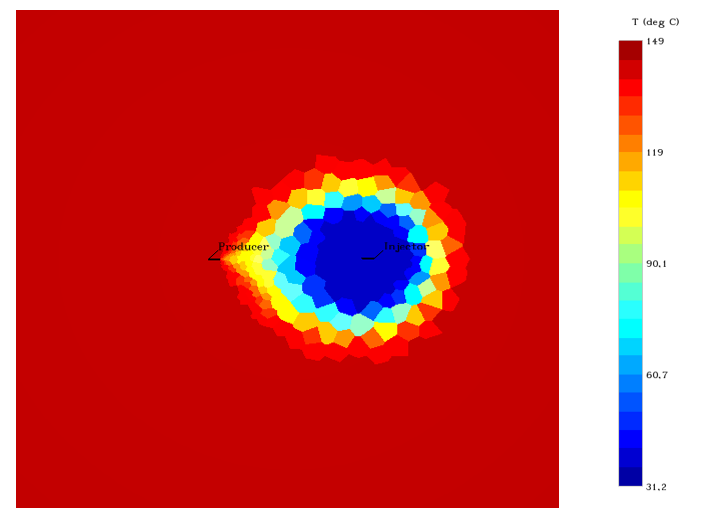
Figure 22. Model simulation of well doublet temperature distribution after 30 years of production—pre-rift phase.